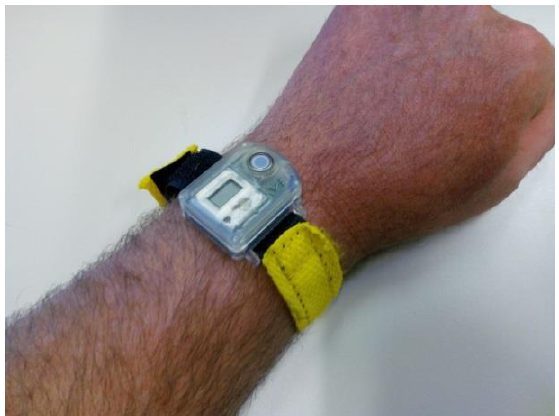
Figure 5. Miniature electronic personal irradiance meter of type SunSaver.